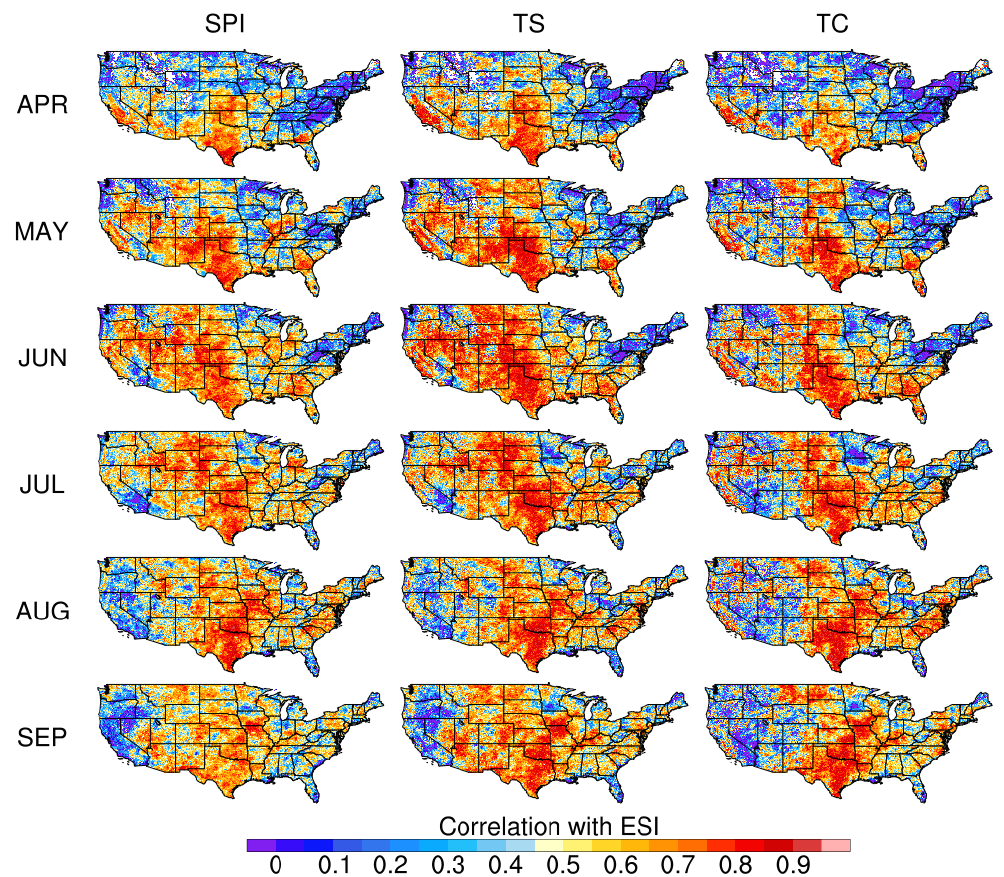
Figure 1. Pearson correlation coefficients between ESI anomalies computed over a 4-week time period and SPI, TS, and TC anomalies computed over a 4-week time period. The correlations were computed separately for each grid point and month using all of the weekly analyses from 2001 to 2015 for which the end of the 4-week period was within a given month. Correlations > 0 . 21 are significant at the p = 0 . 1